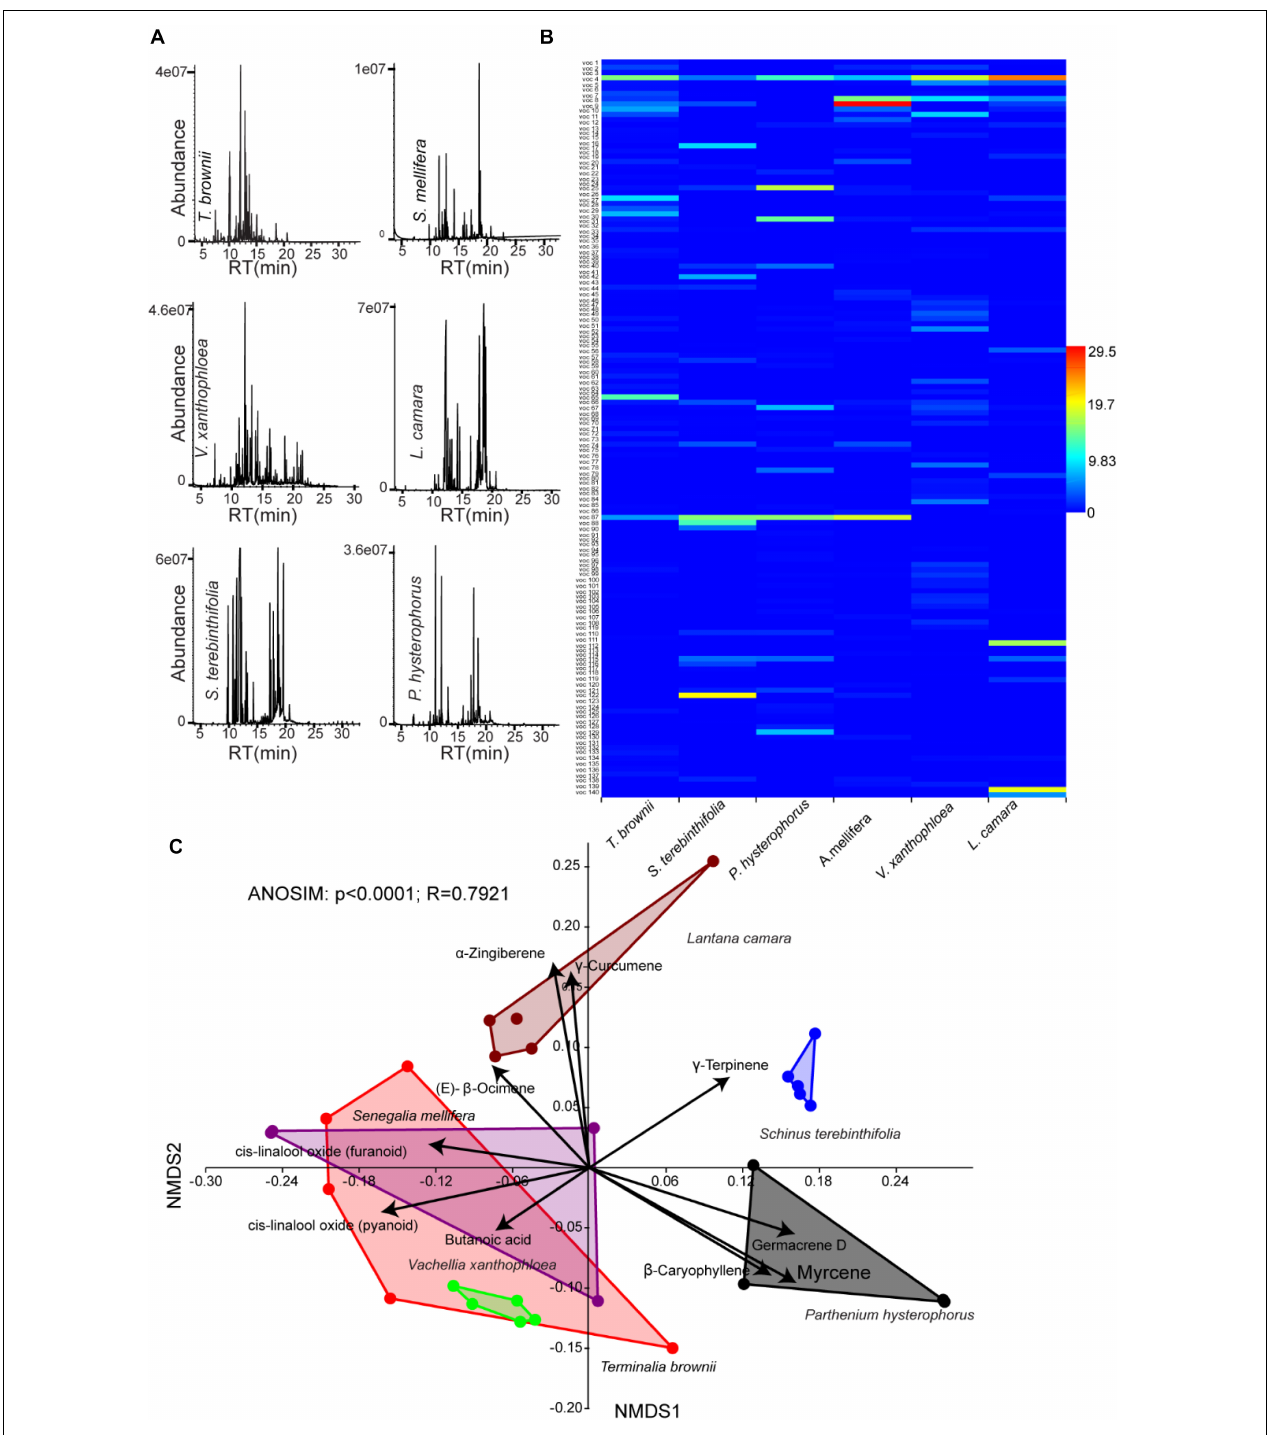
FIGURE 3 | Variations in volatile organic compounds across plant species. (A) Representative gas chromatography/mass spectrometry chromatograph of the six plant species including Terminalia brownii , Senegalia mellifera , Vachellia xanthophloea , Lantana camara , Schinus terebinthifolia , and Parthenium hysterophorus . (B) Heat map generated from 140 volatile organic compounds (VOCs) ( Supplementary Table 1 ) released from the six plant species which stable flies fed on (C) . Multivariate analysis of floral VOCs in six species of plant fed on by stable flies by non-metric multidimensional scaling with a stress value of 0.1448. Black arrows represent overlaid bi-plot analysis of predominant compounds along each